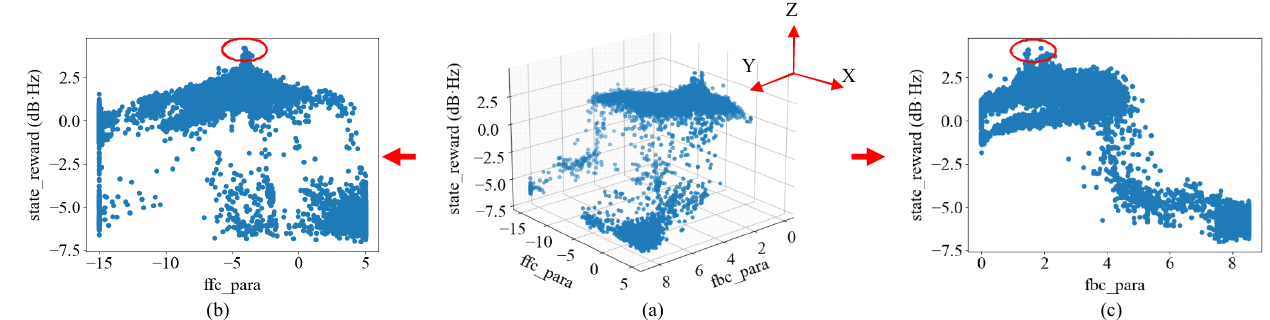
Figure 14. The learning results: ( a ) 3D scatter diagram of state reward and multiple parameters; ( b ) the projection of (a) on the opposite of the “Y” direction; ( c ) the projection of ( a ) in the “X” direction.